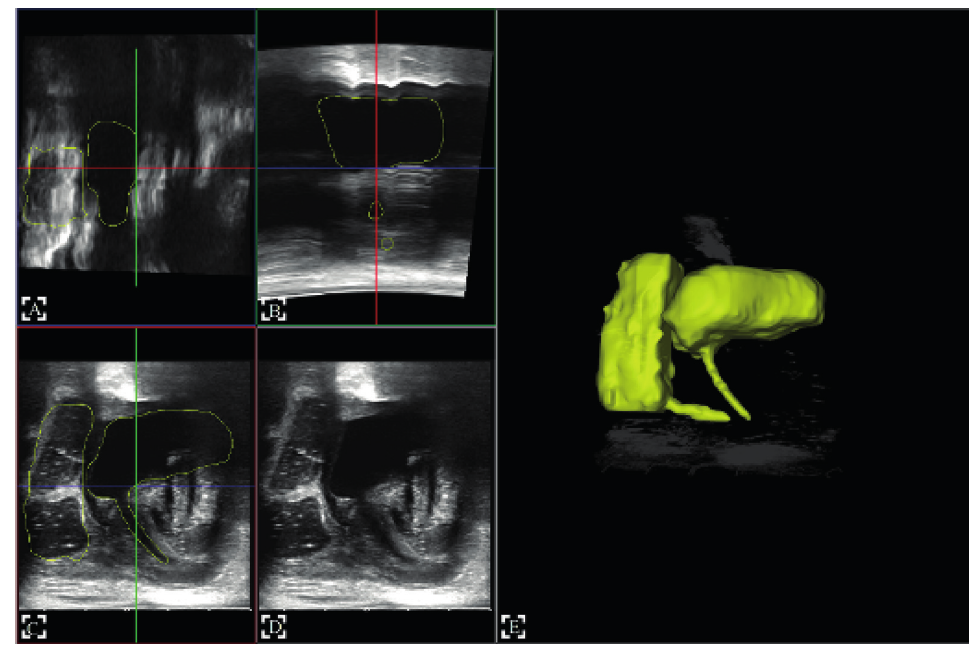
Fig. 2 3D reconstruction process: on the left side respectively two coronal ( A, B ) and two sagittal cuts ( C, D ) created from the ultrasound acquisition, which are used to automatically reconstruct the structure, shown on the right side ( E